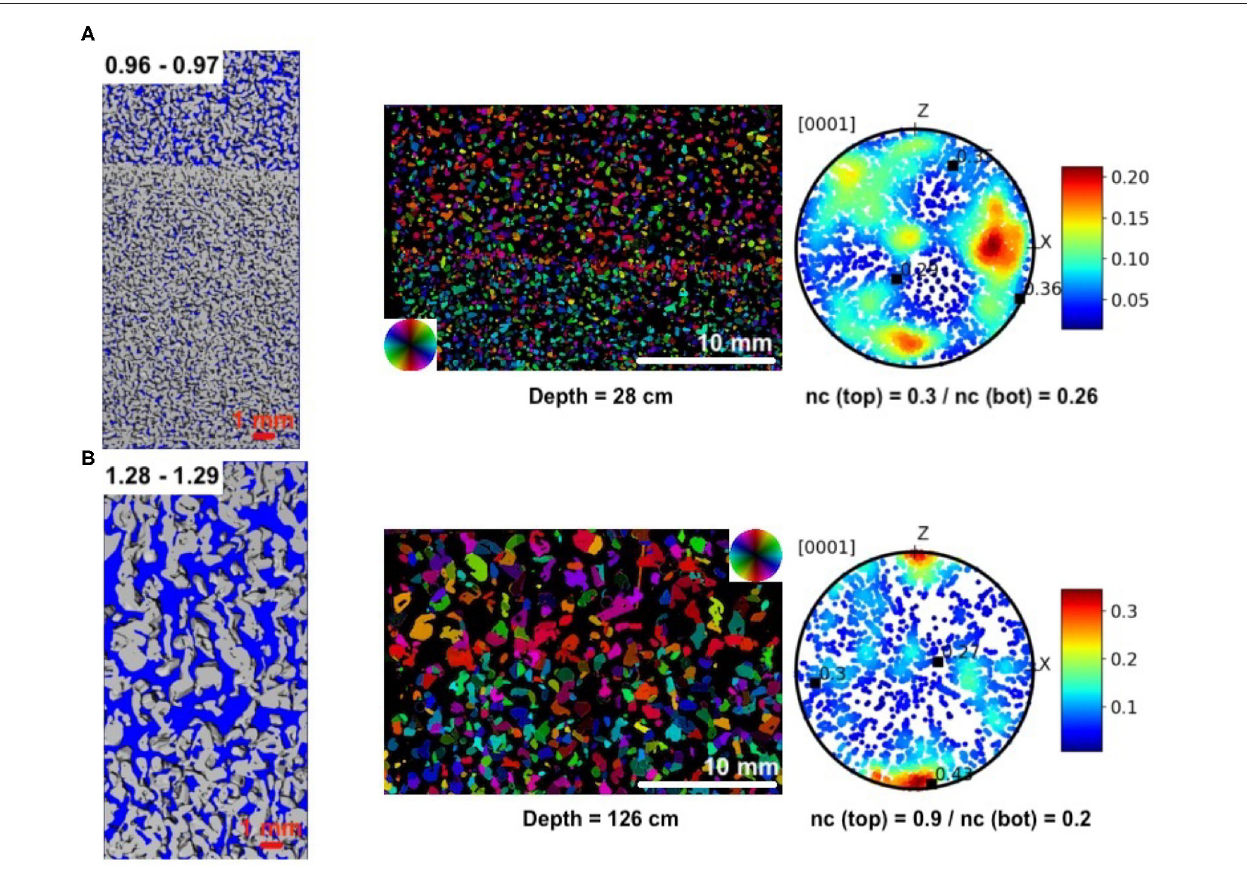
FIGURE 6 | MicroCT structure, microstructure and c -axis pole figure from samples extracted at 28 (A) and 126 (B) cm depth along the EastGRIP snow pit. A corresponding range of ǫ values is given in the microCT structure. The figures of microstructure are color-coded with the colorwheel that represents orientations of the c-axis. On the pole figures, 5,000 pixels are plotted. The black squares correspond to the location of the eigenvectors of a (2) , and the associated eigenvalues are given. nc is the cluster index. The z-axis is the same for the three